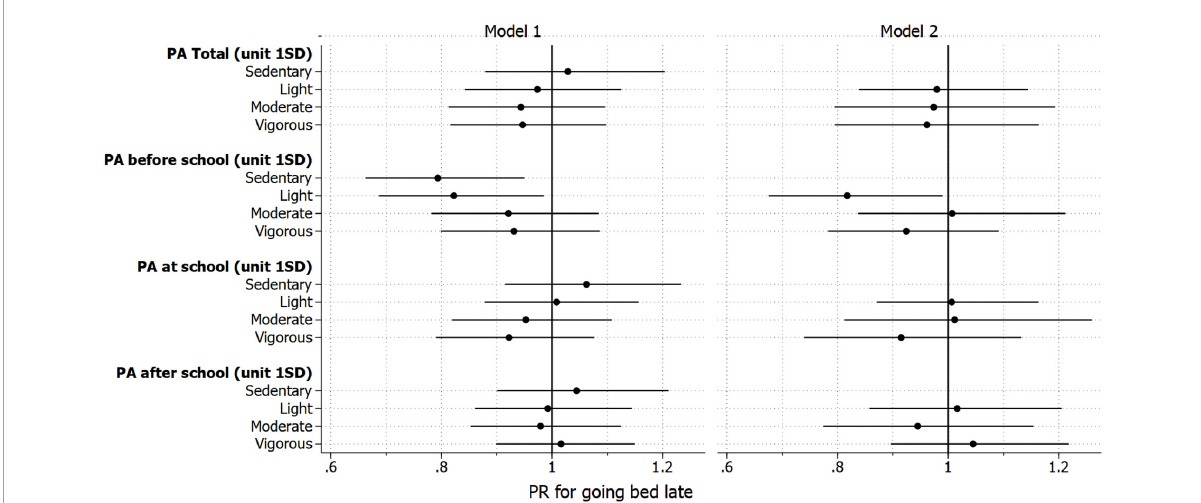
FIGURE3 Association between physical activity (PA) and late sleeping habit; late sleeping habit was defined as 10 p.m. or later for fourth graders and 11 p.m. or later for eighth graders; sedentary behavior: 0.9–1.5 METs; light: > 1.5 to < 3.0 METs; moderate: 3.0 to < 6.0 METs; vigorous: 6.0 to < 20.0 METs; model 1 was adjusted for grade, gender, household income, body mass index, belonging to a sports club, and wake-up time; each physical activity variable was separately included; model 2 was further mutually adjusting for light, moderate, and vigorous intensities of physical activity in the same timing of the